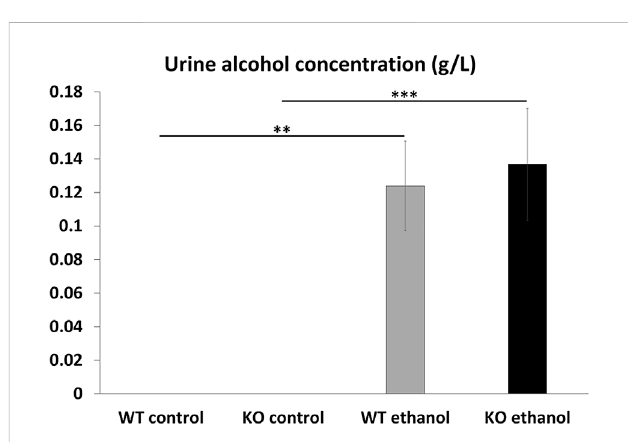
FIGURE 2 Urine alcohol concentration. Quantitative evaluation of alcohol concentration in the urine of wildtype (WT) and Trpa1 knockout (KO) mice, 2 h after i.p., saline (control) or 1 g/kg ethanol injection. Columns show means ± SEM of alcohol concentration (g/L) ( n = 6 – 8; ** p = .002; *** p = .0009; Tukey ’ s post hoc test upon two-way